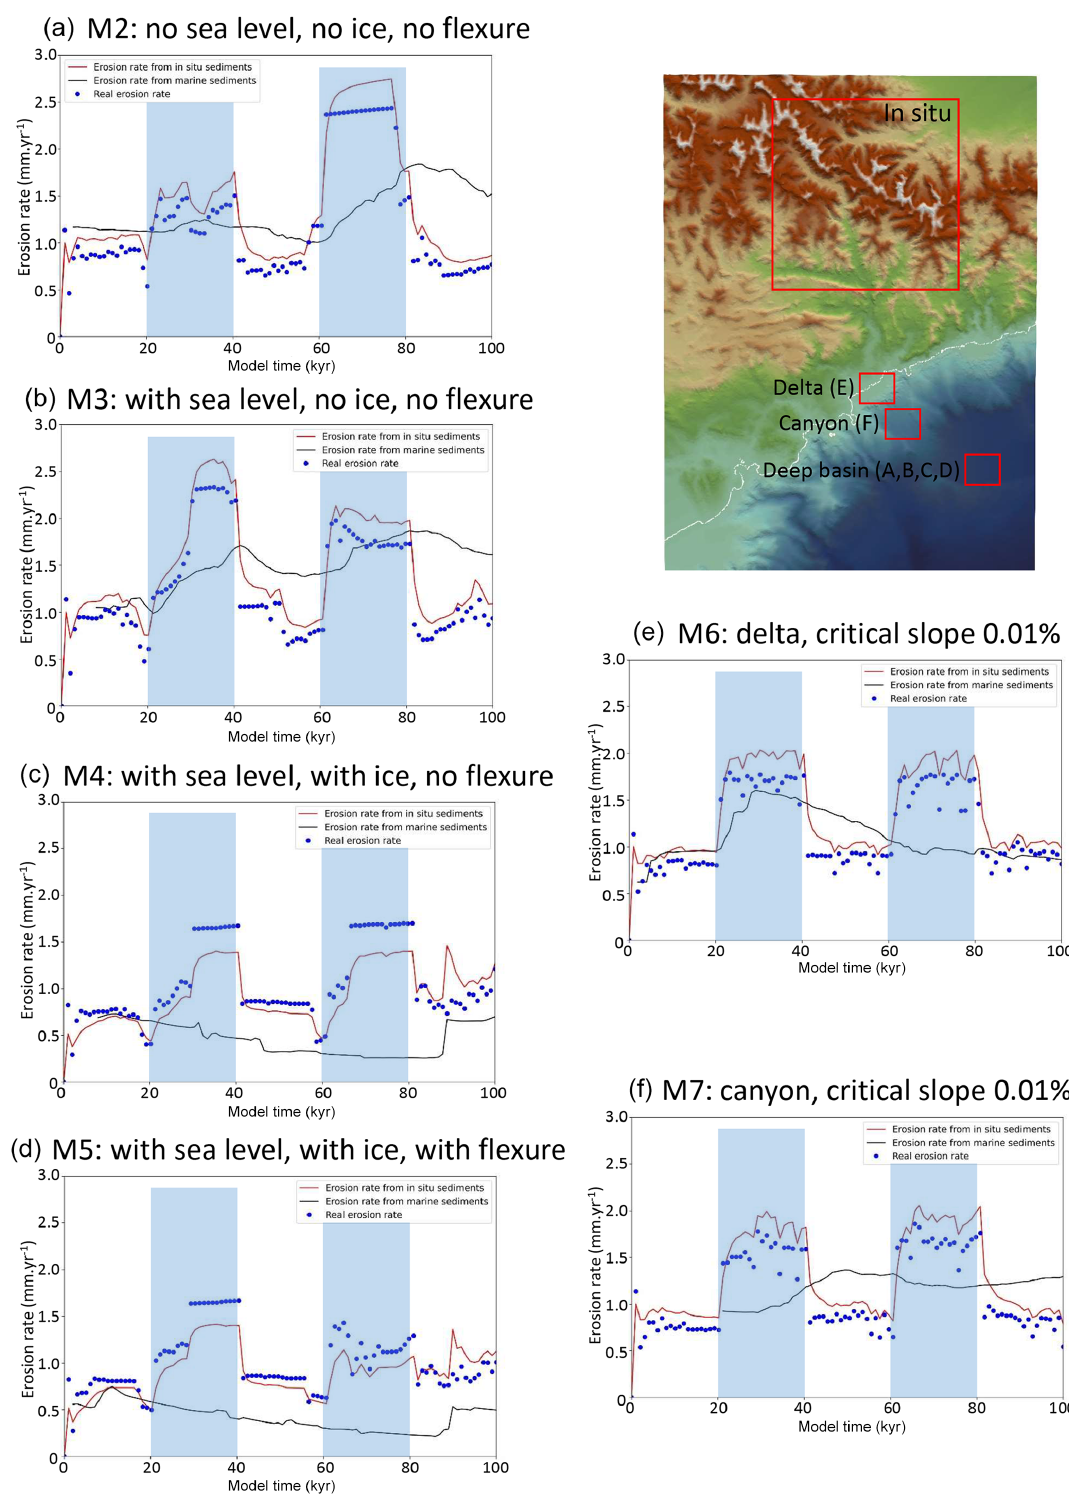
Figure 6. Test of the apparent denudation rates given by the 10 Be concentration of in situ (red line) and deep marine ( 10 Be MS , black line) sediments versus the actual one extracted from the model (blue dots). Periods of large precipitation rates are indicated by the transparent blue vertical strips. (a) Model with only variable precipitation rate; (b) model with variable precipitation rate and sea level variations; (c) model with variable precipitation rate, ice cover and sea level variations; (d) model with variable precipitation rate, sea level variations, ice cover and flexure; (e) model similar to (a) but with a lower critical slope for sediment deposition and forced deposition below − 200m; (f) model similar to (e) but with forced deposition below −